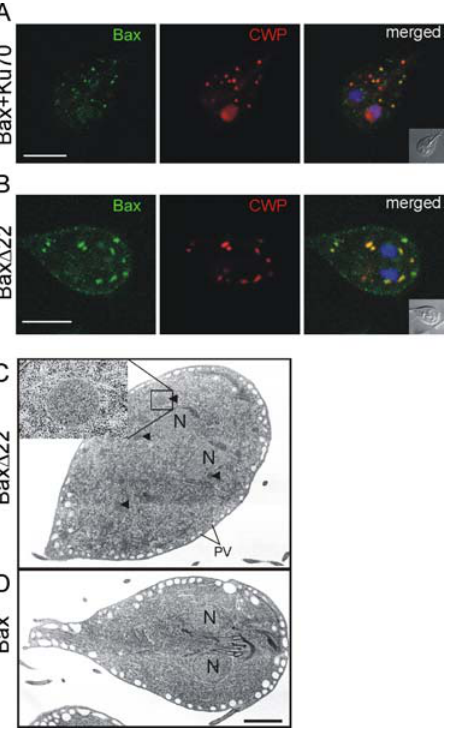
Figure 3. CWP release from ESVs is Bax specific . A) ESVs in encysting Bax-expressing cells treated with the membrane-permeable Bax- inhibiting peptide Ku70 are at least partially protected. Note the co- localization of Bax (green) with (partially intact) ESVs and significantly less cytoplasmic or nucleoplasmic CWP signal than in untreated cells (compare with FIG. 2C).16-May B) Deletion of the Bax C-terminus uncouples Bax targeting to ESV membranes and CWP release. Bax D 22 lacks the C-terminal 22 amino acids of Bax and localizes to membranes of intact ESV. C, D) Electron micrographs of representative cells expressing Bax or Bax D 22 at four hours post induction. C) Encysting trophozoite from the population expressing Bax D 22 showing numerous ESVs with electron dense material (arrowheads). ESV and general compartment morphology are indistinguishable from wild type cells (not shown). Enlarged region shows an individual ESV. Peripheral vesicles underlying the plasma membrane are clearly visible. D) ESVs or organelle remnants are not present in surviving cell expressing Bax. Nuclei, and parts of the microtubule structures of the anterior flagella and significantly enlarged PVs are visible. N, nuclei. Scale bars: 2 m